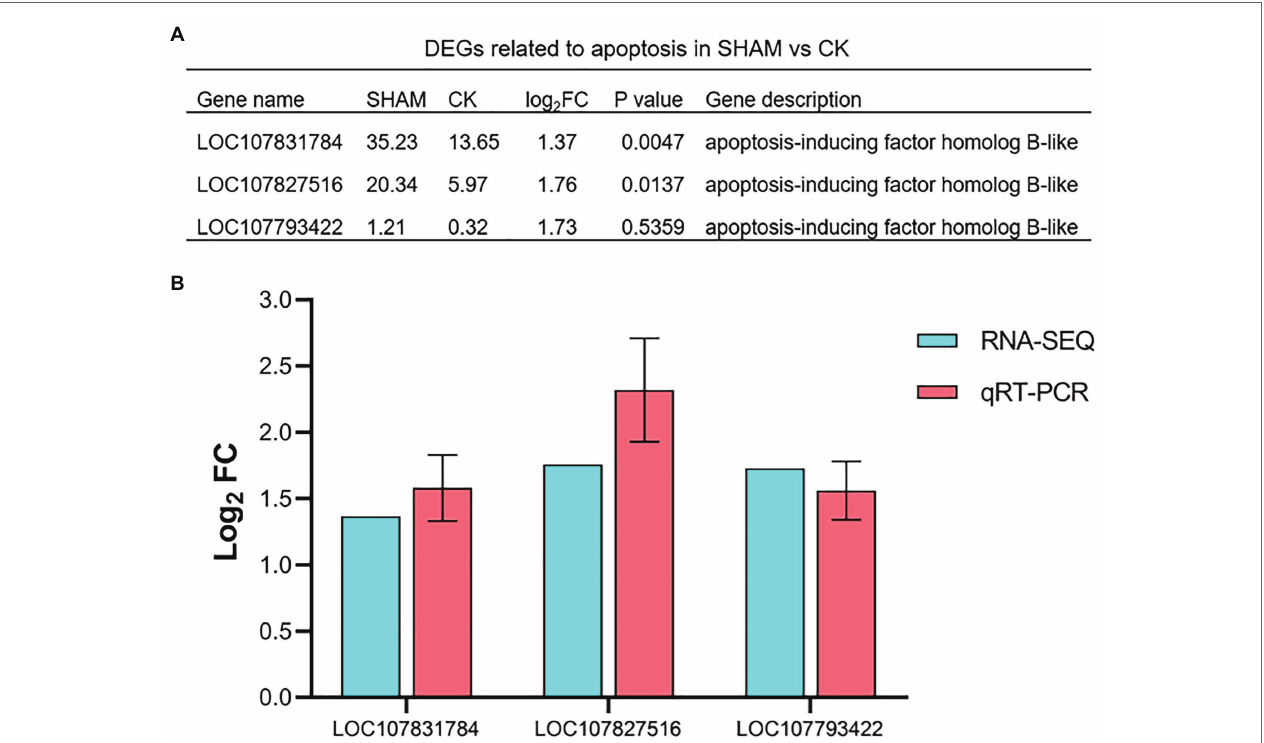
FIGURE 9 | Relative expression levels of apoptosis-related genes in response to SHAM treatment. DEGs related to apoptosis (A) and their quantitative analysis by qRT-PCR. (B) . log 2 FC, log 2